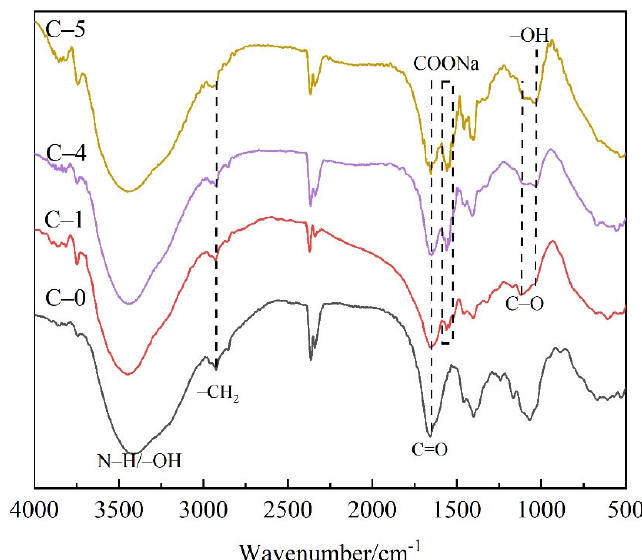
Figure 3. FTIR spectra of transparent flame ‐ retardant hydrogels.